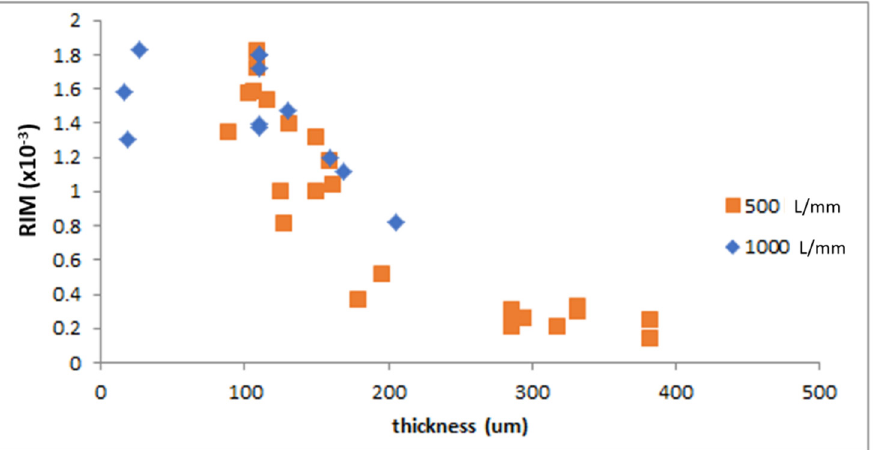
Figure 7. Maximum RIM achieved for individual samples with different thicknesses and spatial frequencies of 500 and 1000 L/mm.